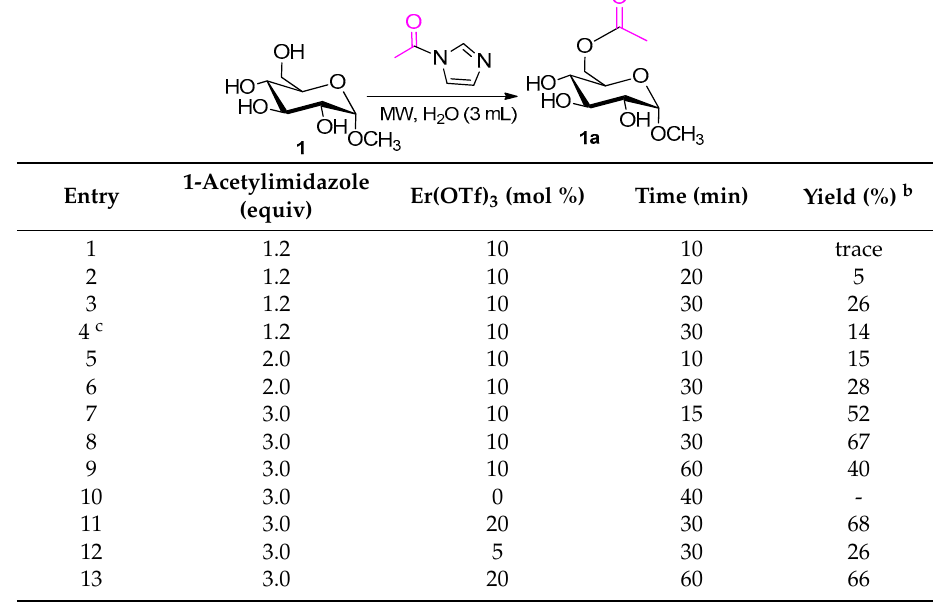
Table 1. Optimization of regioselective acetylation of methyl α‐ D ‐ glucopyranoside as the model substrate. a